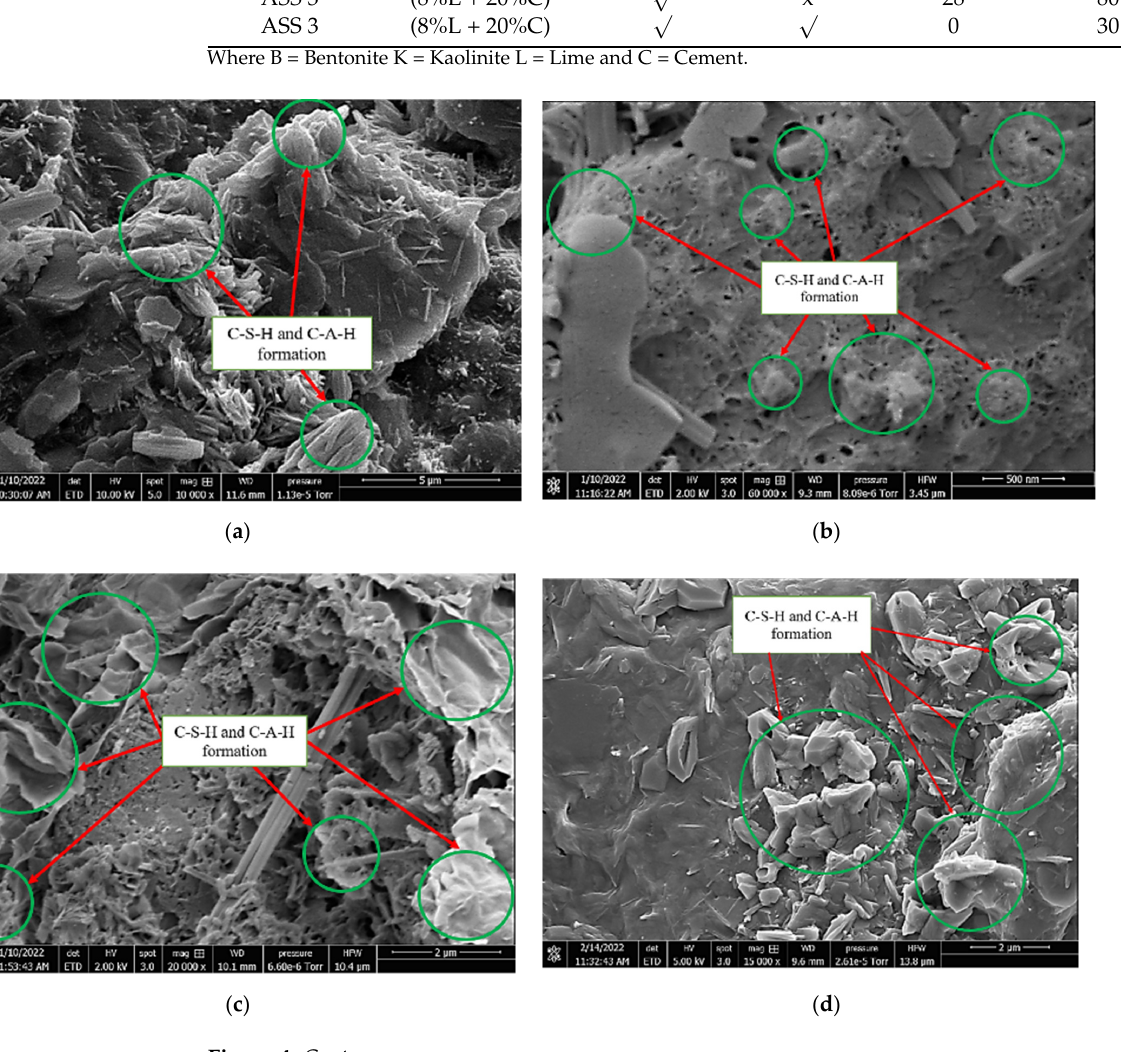
( f ) Figure 4. ( a ) Scanning Electron Microscopy (SEM) image results for ASS 1 after 7 days of curing; ( b ) SEM image results for ASS 2 after 7 days of curing; ( c ) SEM image results for ASS3 after 7 days of curing; ( d ) SEM image results for ASS 1 after 28 days of curing; ( e ) SEM image results for ASS 2 after 28 days of curing; ( f ) SEM image results for ASS 3 after 28 days of curing.